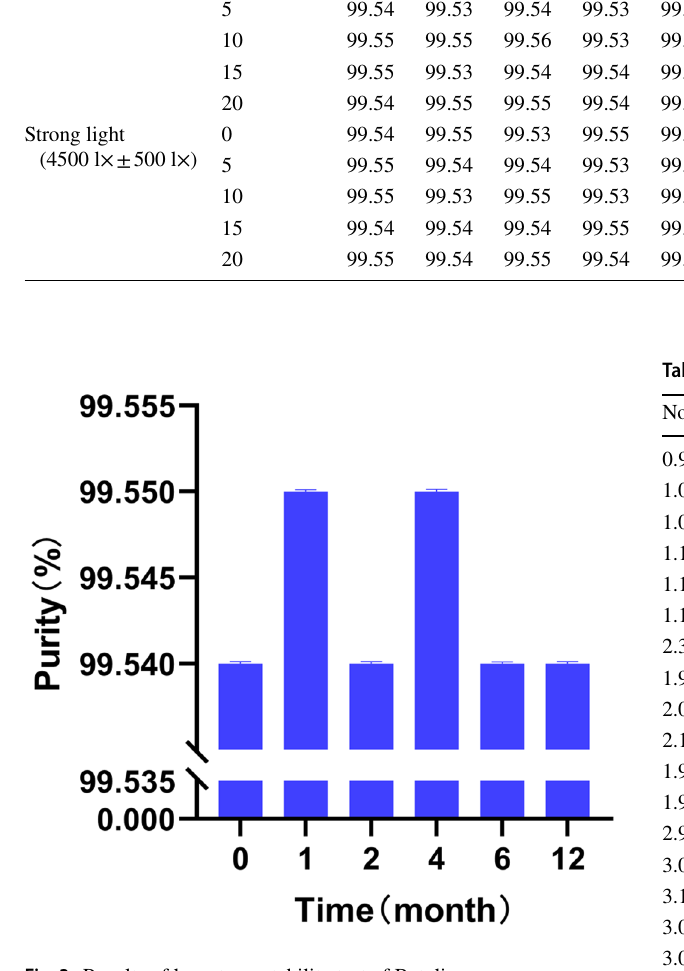
Fig. 3 Results of long-term stability test of Betulin